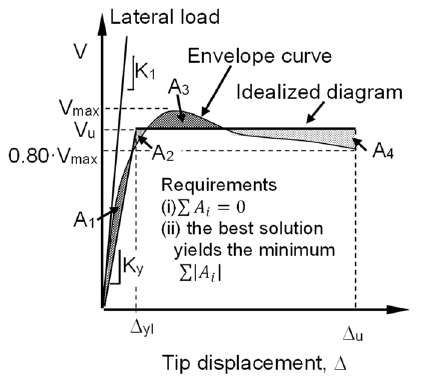
Figure 9. Idealized lateral load–drift ratio curve.